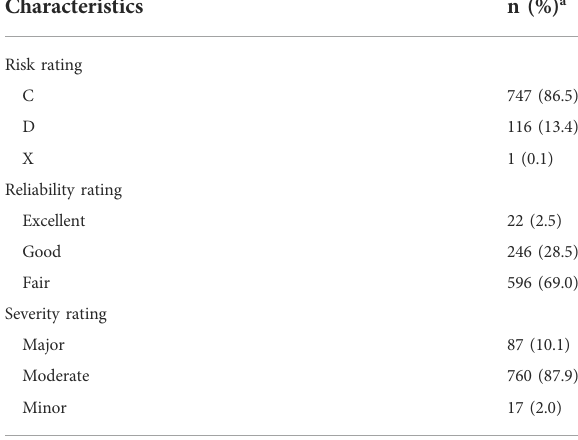
TABLE 4 Characteristics of drug interactions at